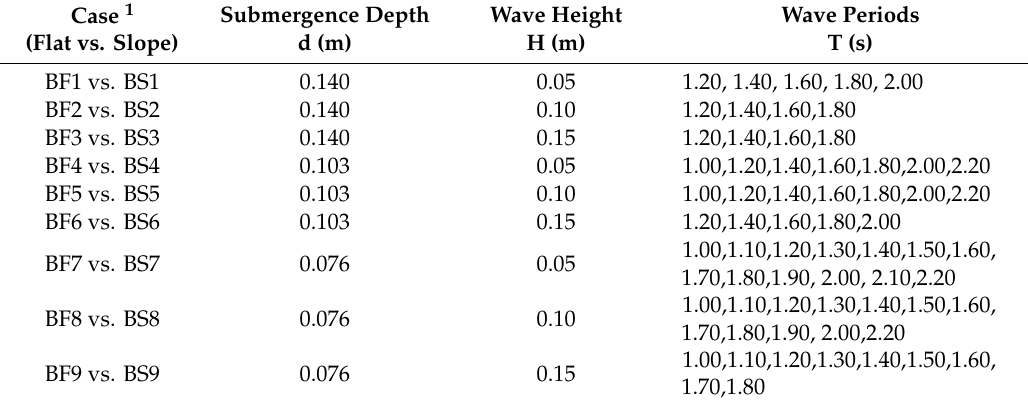
1 BF indicates regular wave cases on a flat bottom and BS indicates cases on a sloped